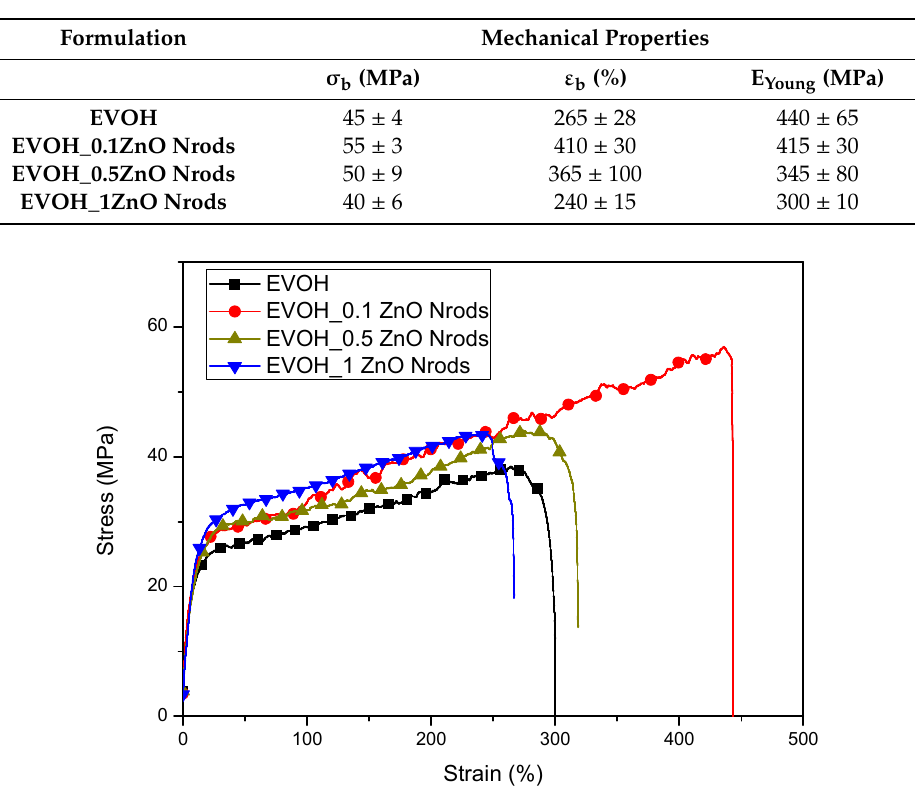
Figure 7. Stress–strain curves of EVOH-based formulations. Table 3. Mechanical properties of EVOH-based systems.